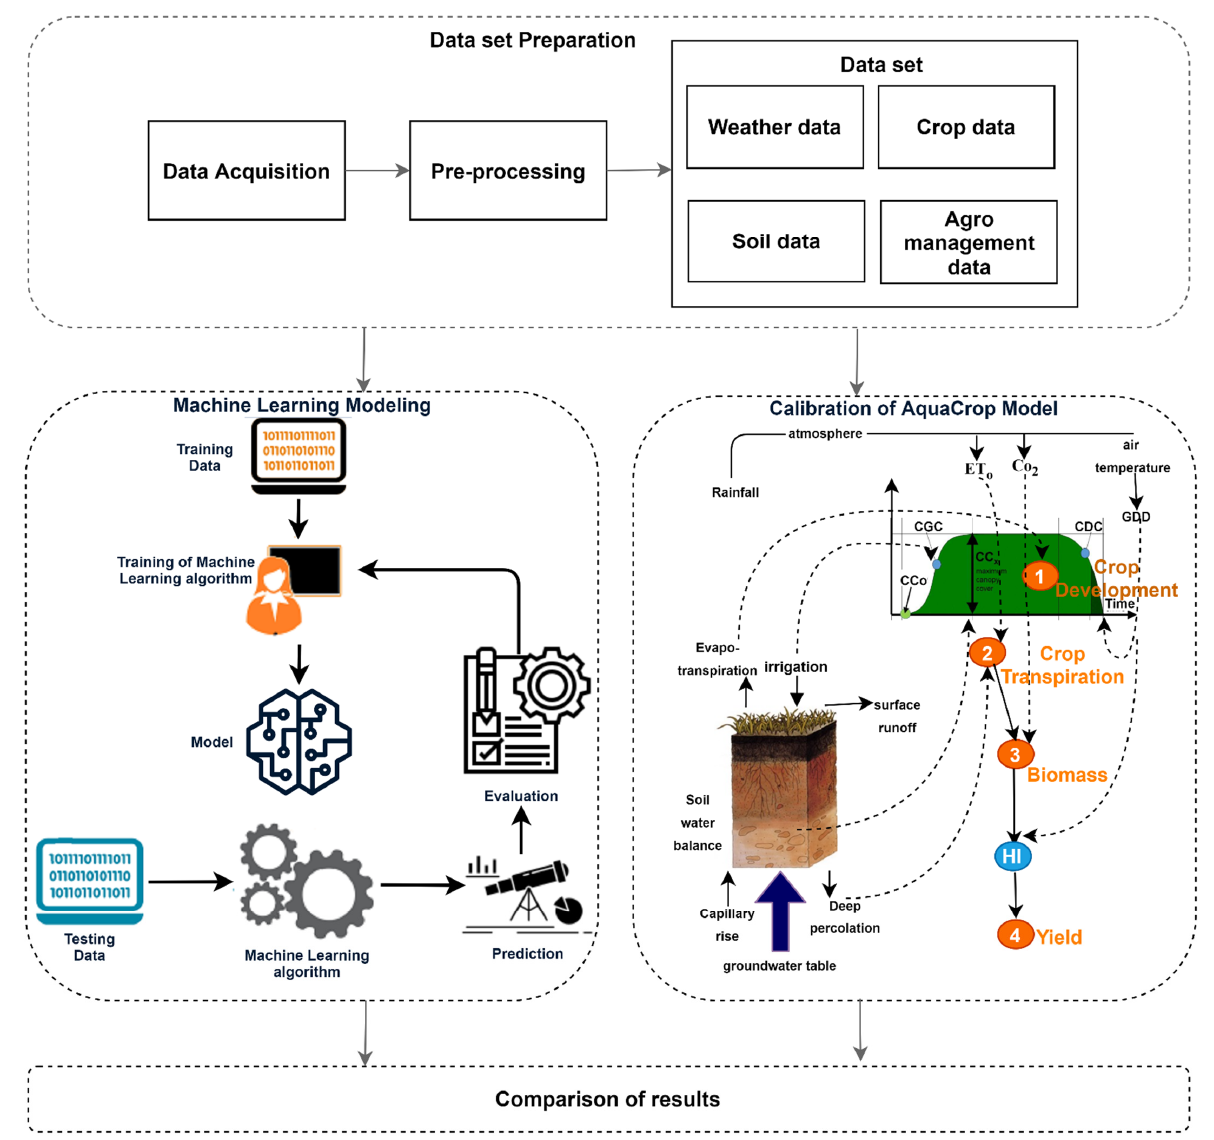
Figure 3. Methodology for the comparative study of tea yield